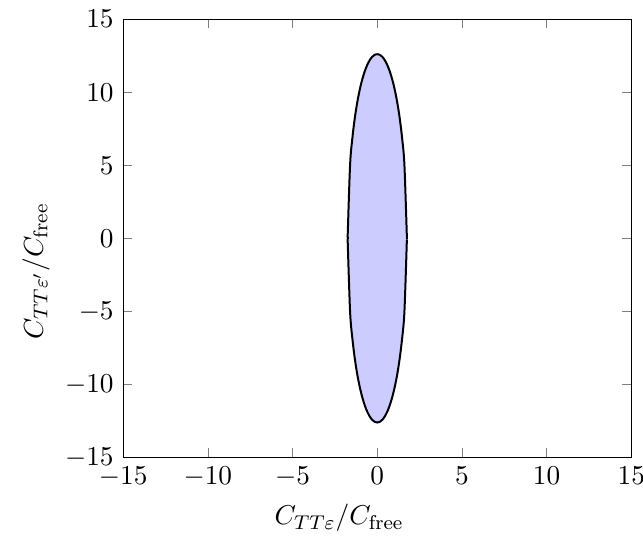
Figure 3 . 3d Ising model allowed region for C TTε and C TTε ′